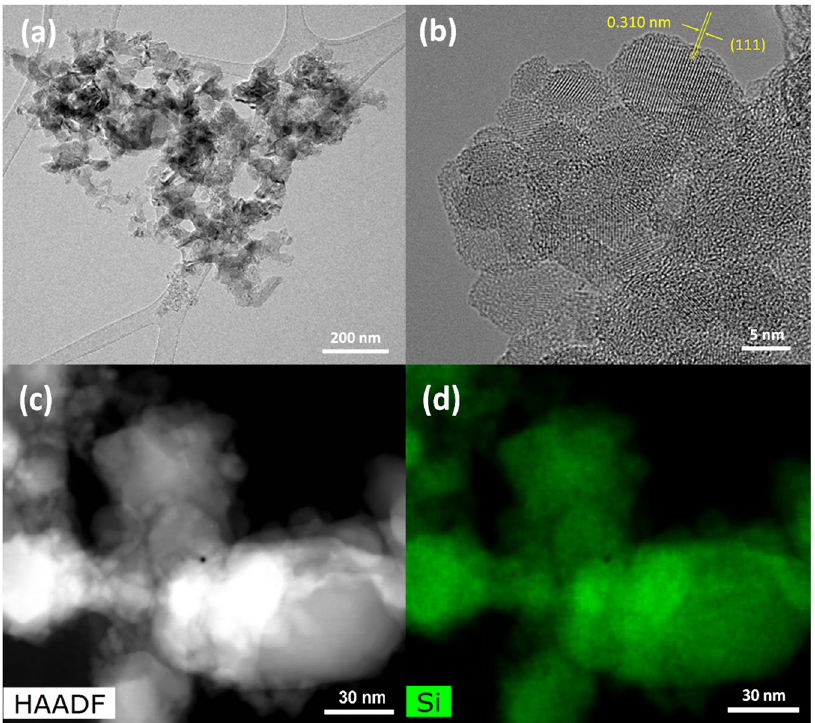
Figure 4. ( a ) Low magnification TEM image of gSi particles. ( b ) HRTEM image of gSi showing the characteristic lattice spacing of Si (111). ( c ) STEM-HAADF image of gSi and ( d ) EDS elemental map showing the high purity of reduced